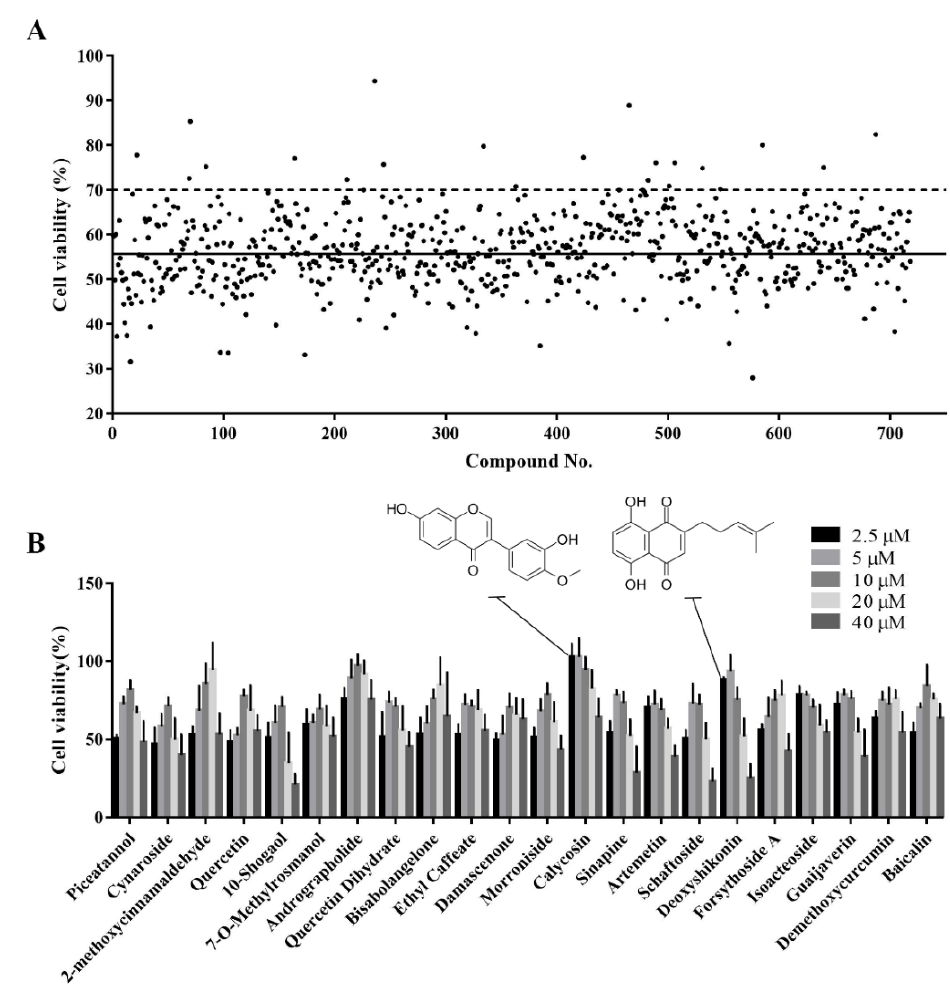
Figure 3. Identification of active monomers from the Chinese herbal compound library using a high-throughput screening assay. ( A ) Primary screening of 718 plant compounds. IPEC-J2 cells were pretreated with the compounds at 10 µ M in 96-well plates for 24 h. Then, they were treated with 1000 µ M H 2 O 2 for 4 h after which cell viability was determined using the CCK-8 assay. Representative cell viability values for the 718 compounds are presented. The black solid line indicates the mean viability of cells treated with H 2 O 2 alone and the black dotted line indicates 70% cell viability. Compounds that maintained cell viability above 70% were considered hits. ( B ) Secondary screening of the hit compounds at different concentrations. IPEC-J2 cells were pretreated with the hit compounds at 2.5, 5, 10, 20, or 40 µ M in 96-well plates for 24 h. Then, they were treated with H 2 O 2 at 1000 µ M for 4 h after which cell viability was determined using CCK-8 assay.